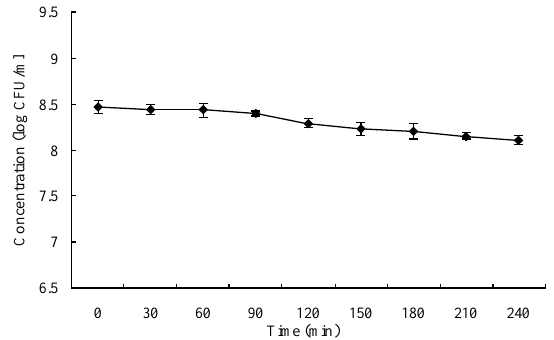
Figure 1. Survival of Lactobacillus plantarum ZLP001 in the presence of hydrogen peroxide. Error bars indicate the standard deviation of three determinations.